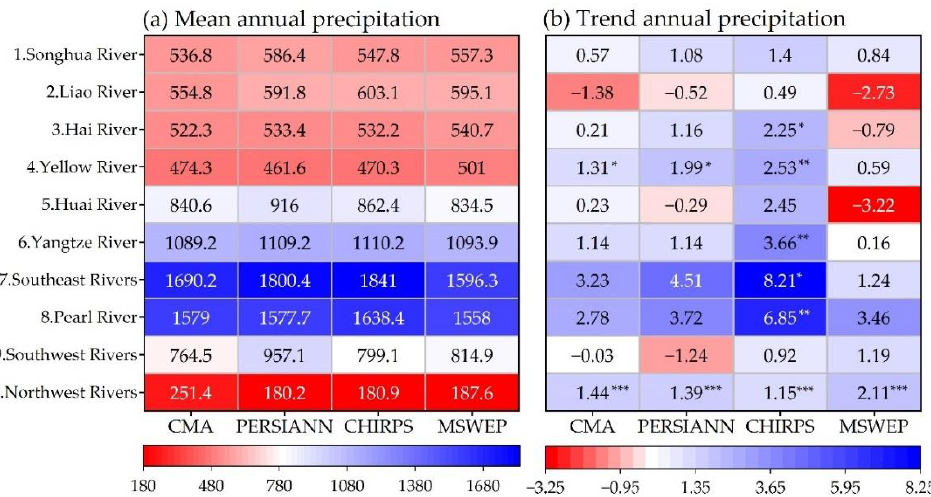
Figure 5. Mean, trend, and significance of annual precipitation for the three RSPEs over the 10 first- level basins during 1983 – 2019; *, **, and *** denote significance at p = 0.05, 0.01, and 0.001, respec- tively.